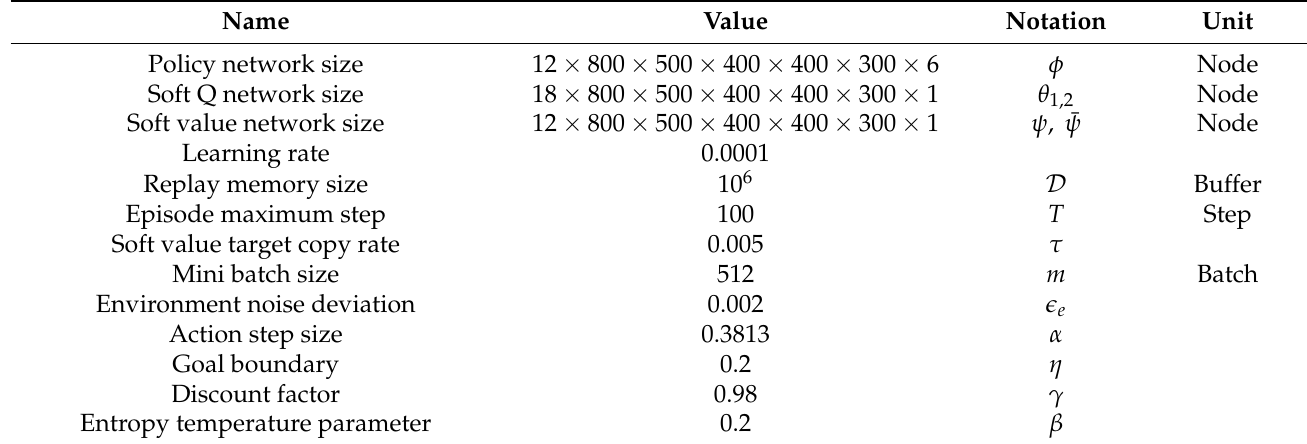
Table 2. Tuning parameters for the designed SAC with